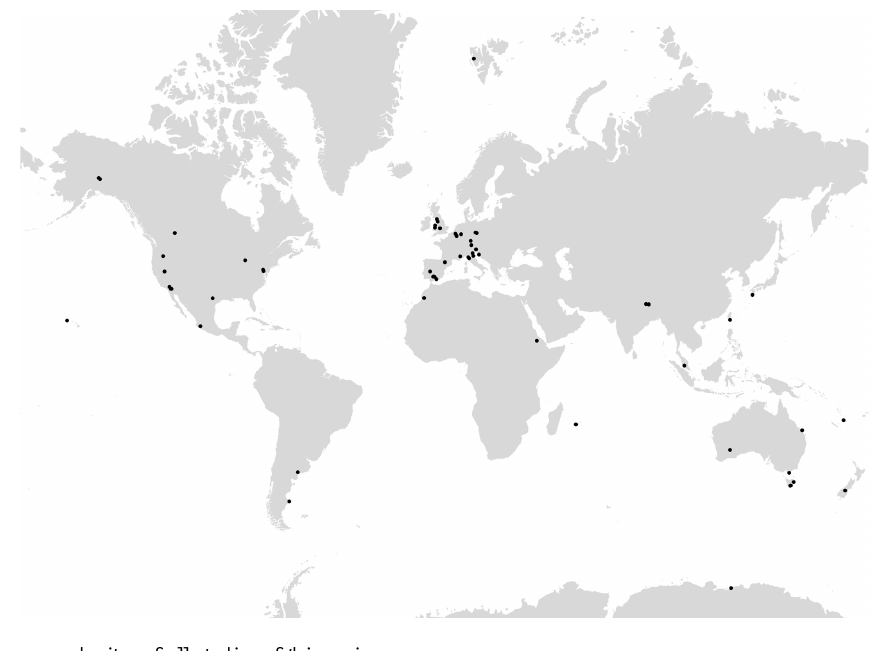
Figure 2. Map of the research sites of all studies of this review.